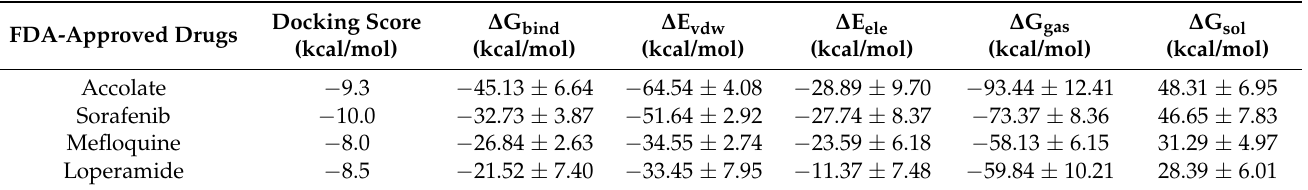
Table 1. Binding free energy (kcal/mol) and the components of binding free energy of the different